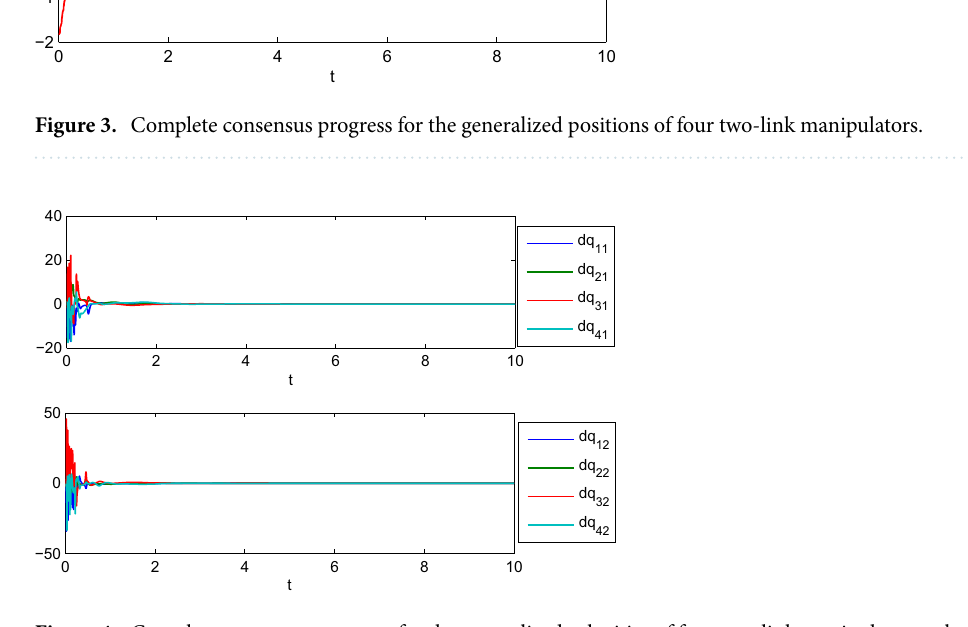
Figure 4. Complete consensus progress for the generalized velocities of four two-link manipulators, where dq i1 and dq i2 represent the 1st and 2nd components of generalized velocities of manipulators i ( i = 1, 2, 3, 4 ) .